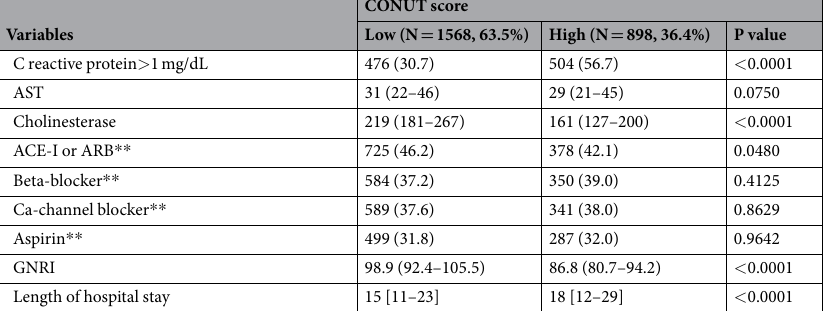
Table 1. Patient Characteristics of the Study Population. * 20 risk-adjusting variables and ** 5 additional risk-adjusting variables selected for multivariable models. || Body mass index was calculated as weight in kilograms divided by height in meters squared. § Anemia was defined by the World Health Organization criteria (hemoglobin < 12.0 g/dL in women and < 13.0 g/dL in men). CONUT = Controlling Nutritional Status; BMI = body mass index; ACS = acute coronary syndrome, HF = heart failure, PCI = percutaneous coronary intervention; CABG = coronary artery bypass graft; BP = blood pressure; bpm = beat per minute; NYHA = New York Heart Association, LVEF = left ventricular ejection fraction; HFrEF = heart failure with reduced ejection fraction; HFmrEF = heart failure with mid-range ejection fraction; HFpEF = heart failure with preserved ejection fraction; BNP = brain-type natriuretic peptide; GFR = estimated glomerular filtration rate, AST = aspartate aminotransferase, ACE-I = angiotensin converting enzyme inhibitor, ARB = angiotensin 2 receptor blocker, GNRI = geriatric nutritional risk index.